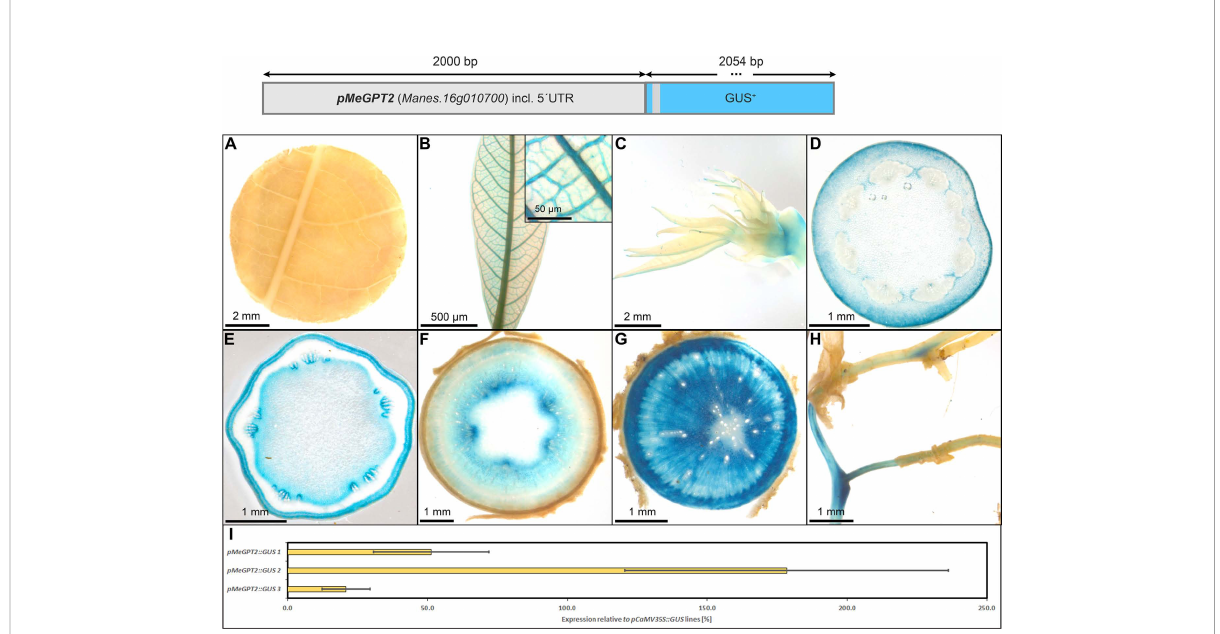
FIGURE 12 Representative GUS staining pattern of four pMeGPT2 promoter-reporter lines. (A) Source leaf, (B) Sink leaf (Inlay = Close-up), (C) Emerging leaves, (D) Petiole cross-section, (E) Upper stem cross-section, (F) Lower stem cross-section, (G) Storage root cross-section, (H) Fibrous roots, (I) GUS expression levels of three pMeGPT2::GUS lines relative to three pCaMV35S::GUS lines in %. Bars represent mean values with standard deviation